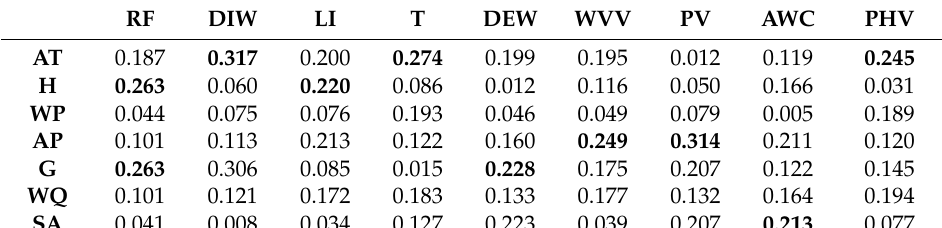
Table 7. Similarity results based on structural strategy.